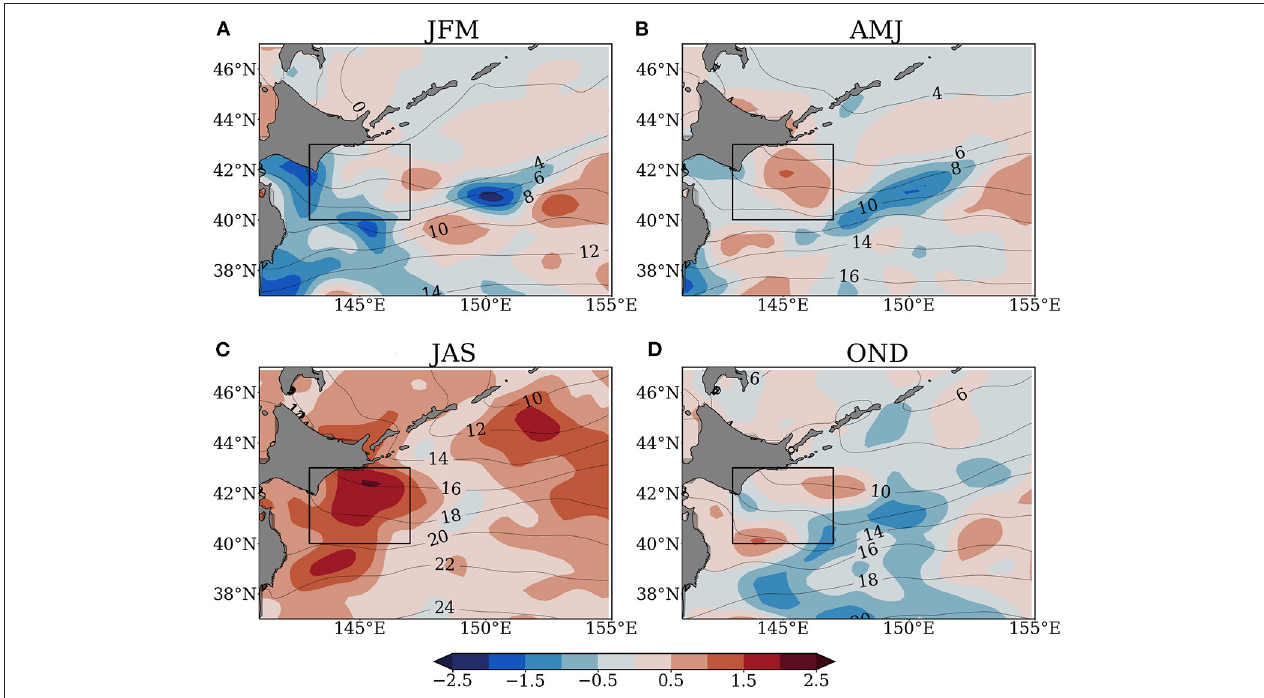
FIGURE 2 | Anomaly of the 2010–2016 mean SST in each season from the 1993–2009 mean (color; ◦ C), and the 2010–2016 mean SST (contour; ◦ C). (A) In JFM. (B) In AMJ. (C) In JAS. (D) In OND.